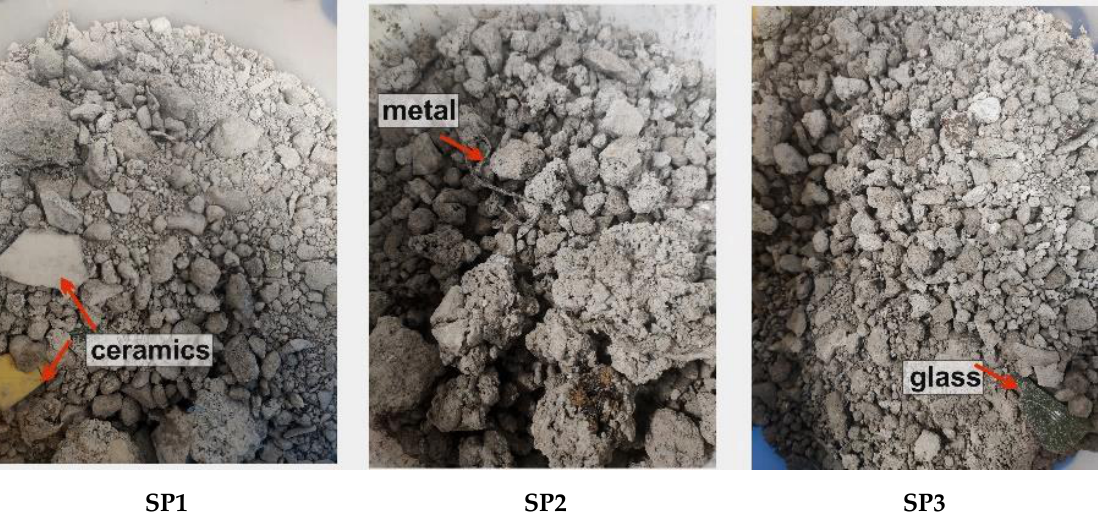
Figure 1. Macrophotographs of raw slag samples with visible, unburnt fragments of municipal waste.